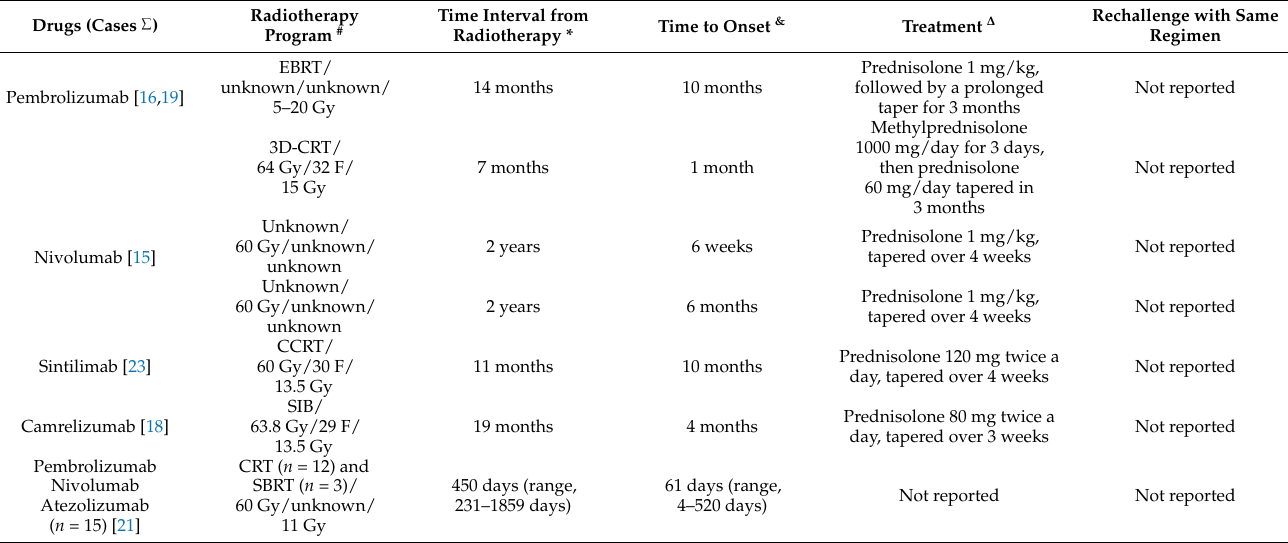
Table 2. Summary of published cases of RRP induced by